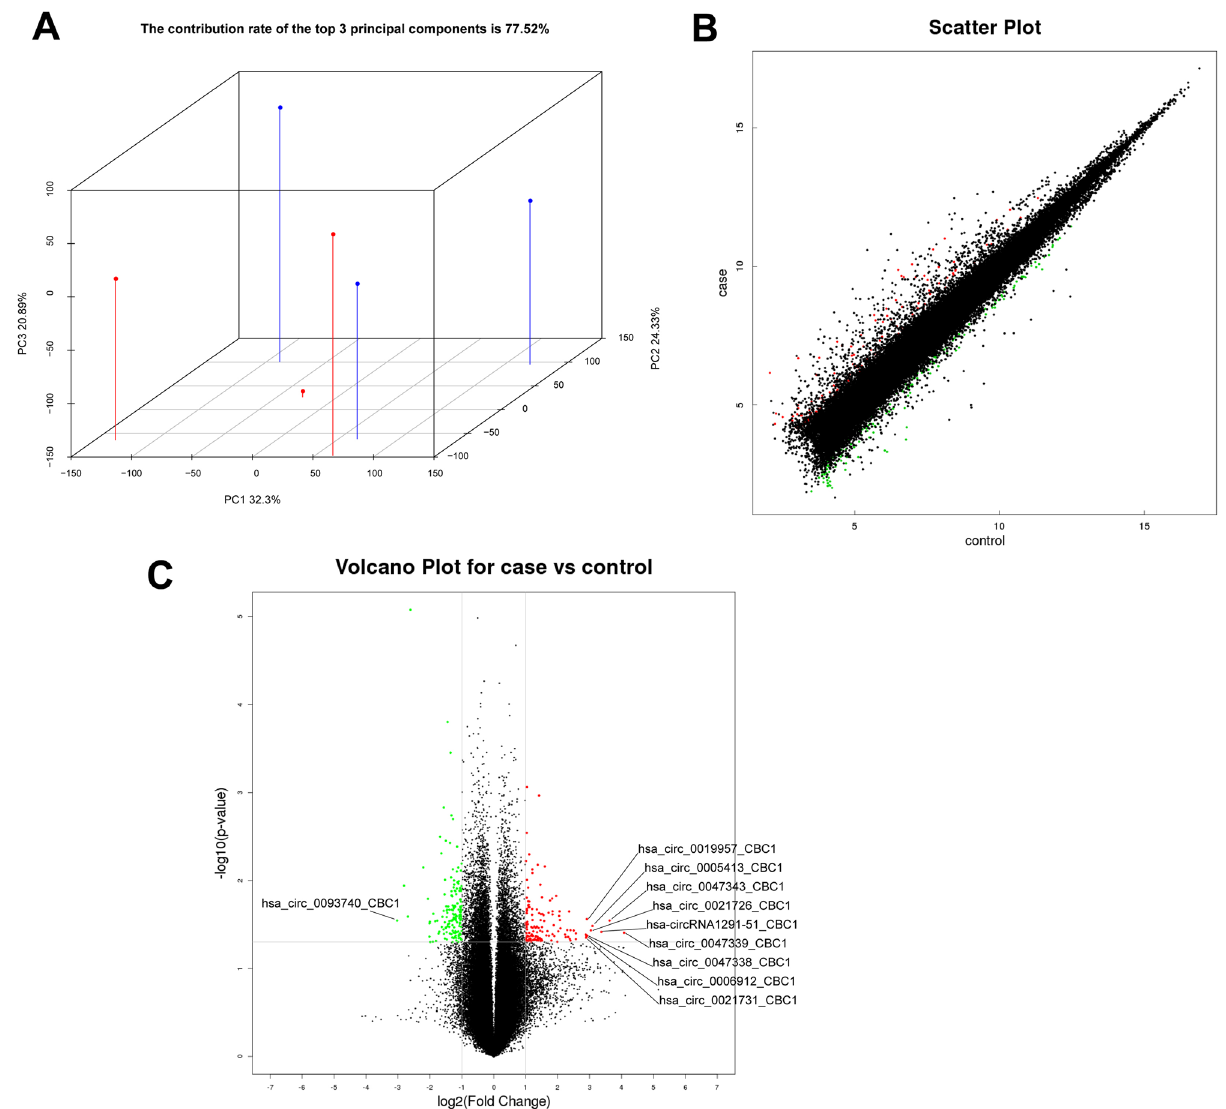
Figure 1. CircRNA expression profile analysis of urethral scar tissue. ( A ) Principal Component Analysis 3D diagram showed three principal components in three-dimensional space, PC1 was the first principal component, PC2 was the second principal component, and PC3 was the third principal component. The percentage in the coordinate axis was the contribution rate of each principal component. Duplicate samples of the same group were marked with the same shape and color. ( B ) Scatter chart showed the signal values of circRNA in each group of samples. ( C ) Volcano map showed the difference of circRNA in two groups of samples. Up-regulated circRNA was marked in red, down-regulated circRNA was marked in green, and circRNA with no significant difference was marked in